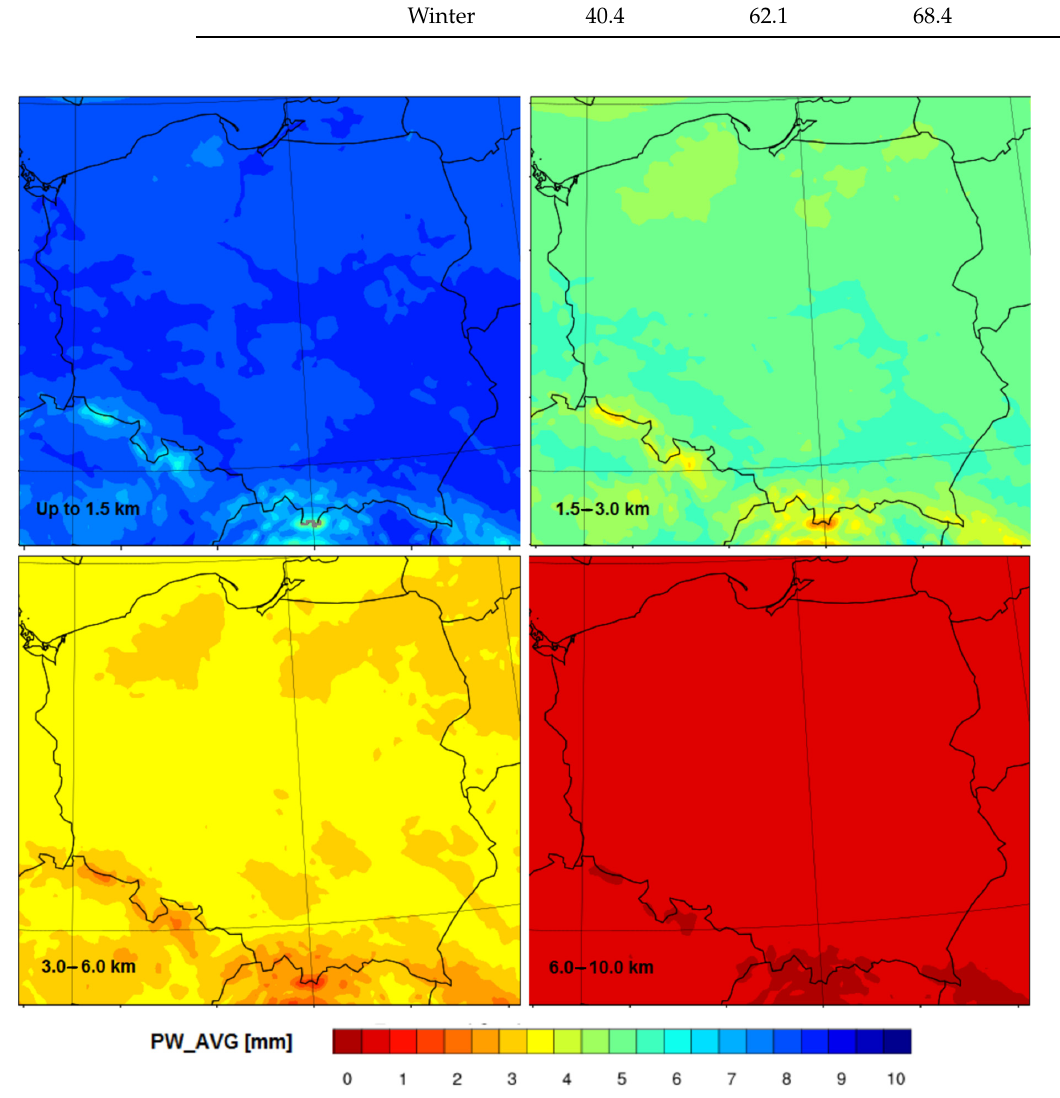
Figure 9. PW annual values (mm) from the years 1981–2010 over Poland at individual levels: up to 1.5 km, 1.5–3 km, 3–6 km and 6–10 km. Grids excluded from the analysis are in gray.